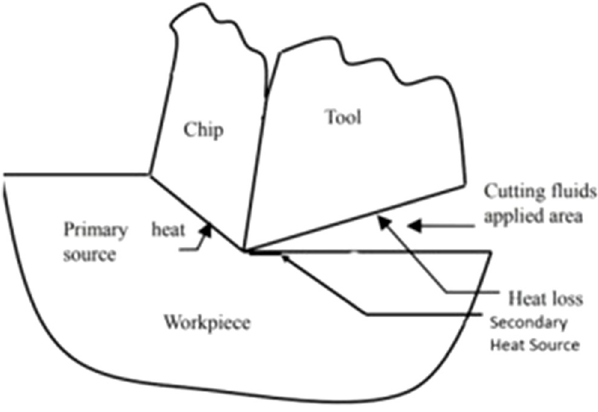
Fig. 4. Illustration of considered heat change